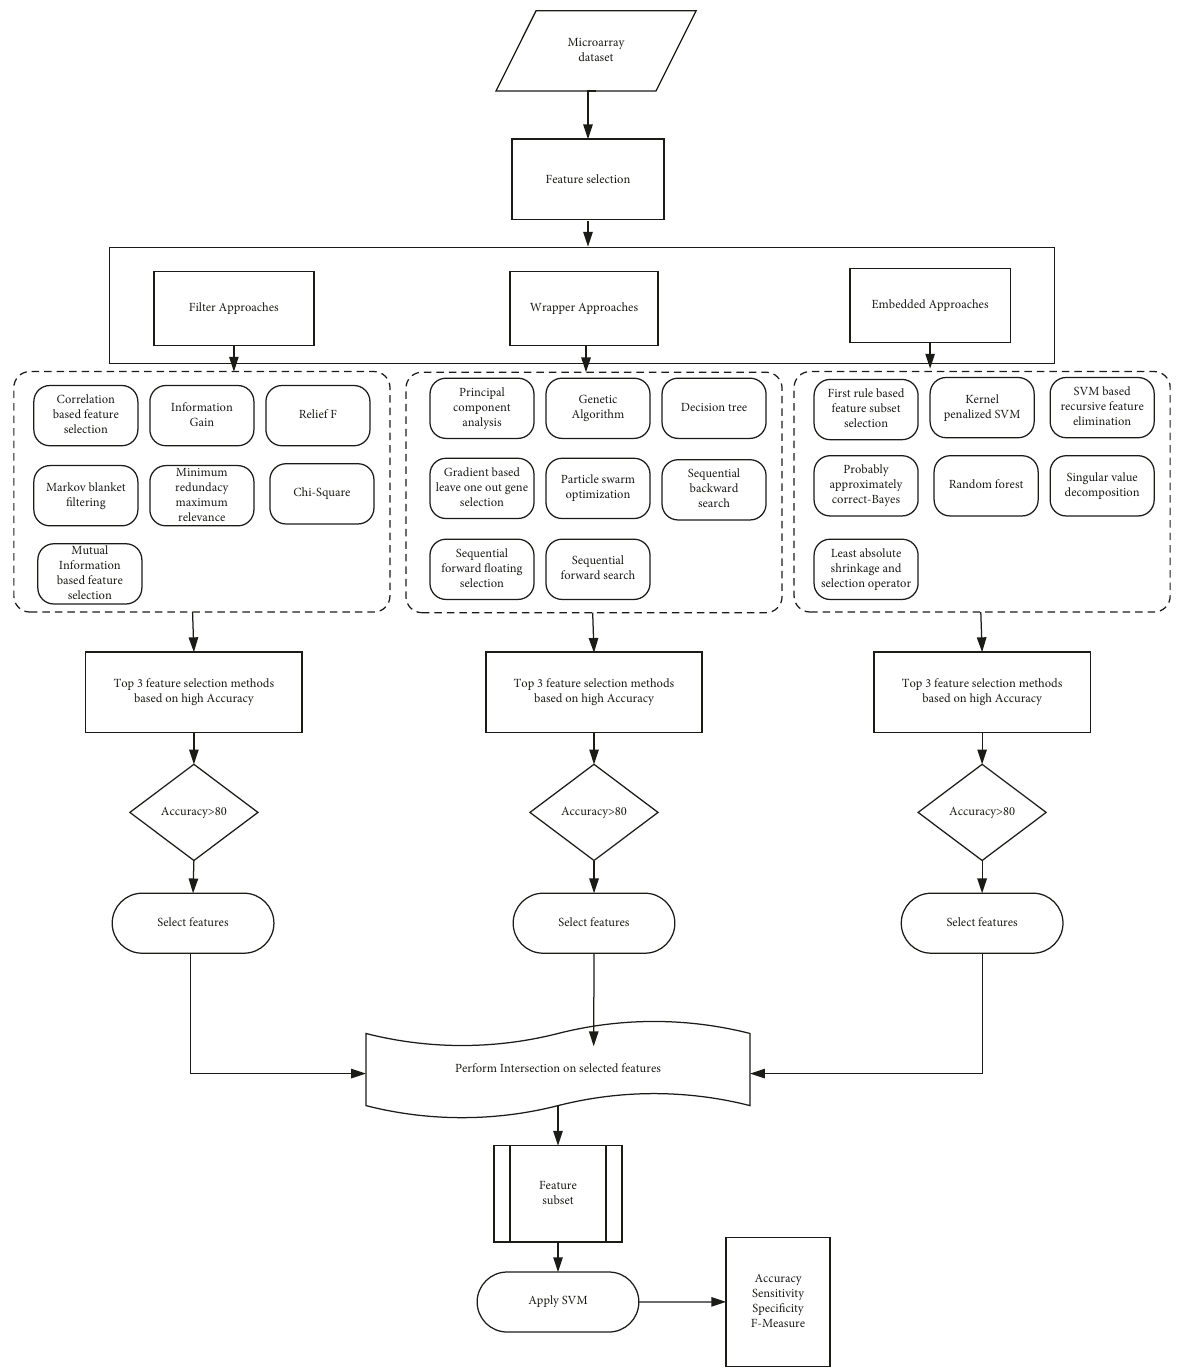
Figure 1: Proposed framework for feature selection and classification.